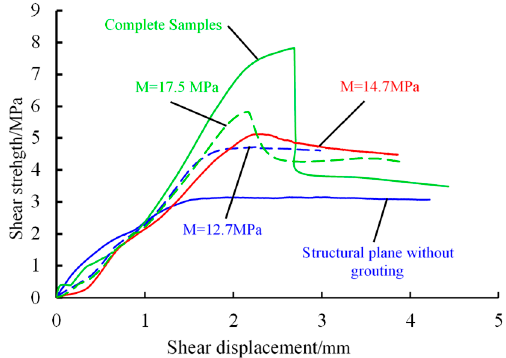
Figure 12. The curve of shearing strength and shearing displacement.